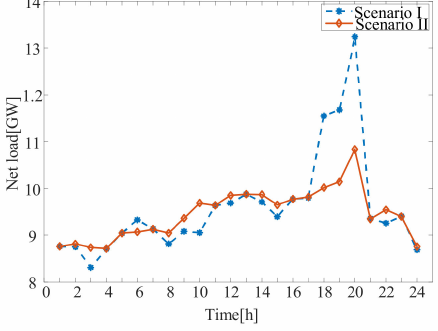
Figure 10. Net load change curves of two scenarios.